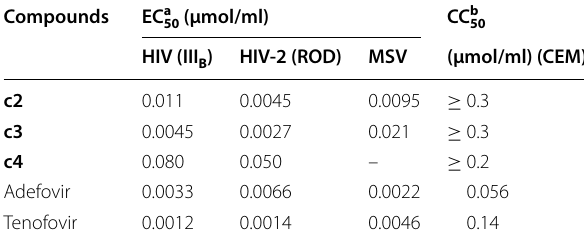
Table 30 Antiviral activity results of test compounds (c2– c4) in cell culture